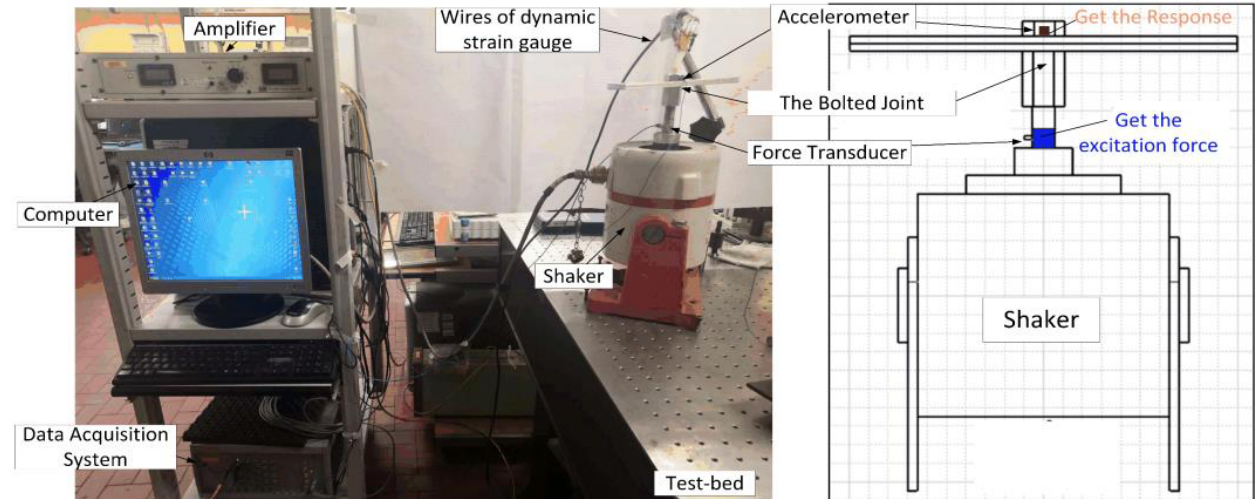
Figure 11. Experimental system for the dynamical tests of the bolted joint.